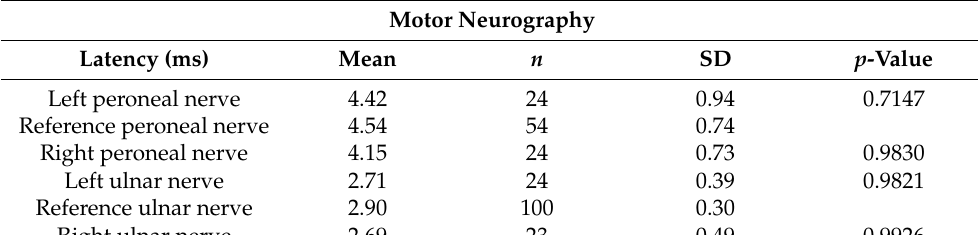
Table 4. Motor neurography latencies for left and right peroneal and ulnar nerves.